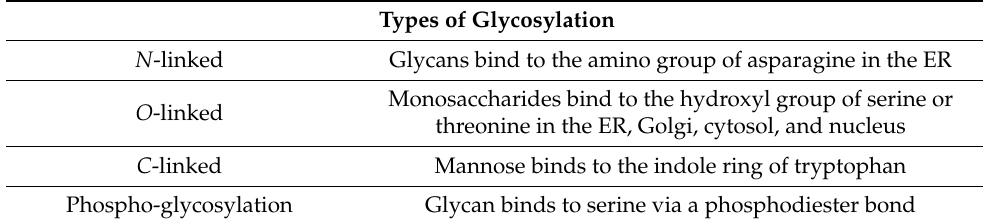
Table 2. A description of the different types of